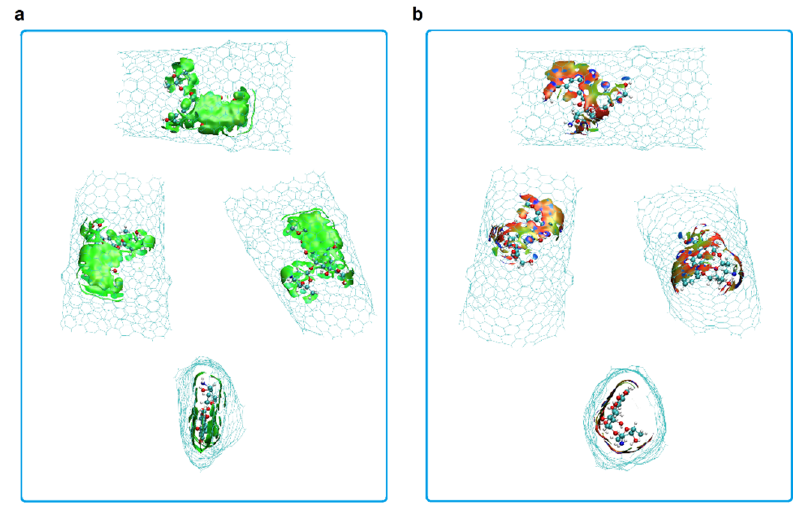
Figure 6. Representation of non-covalent interactions (NCI) for DOX encapsulation inside chiral carbon nanotubes having two haeckelite defects. (a) DOX D position; (b) DOX R position. Cutplot 0.01 0.1. Blue surfaces indicate strong interactions; green means weak interactions; red means repulsion [47]. Different comparative lateral and frontal views shown.